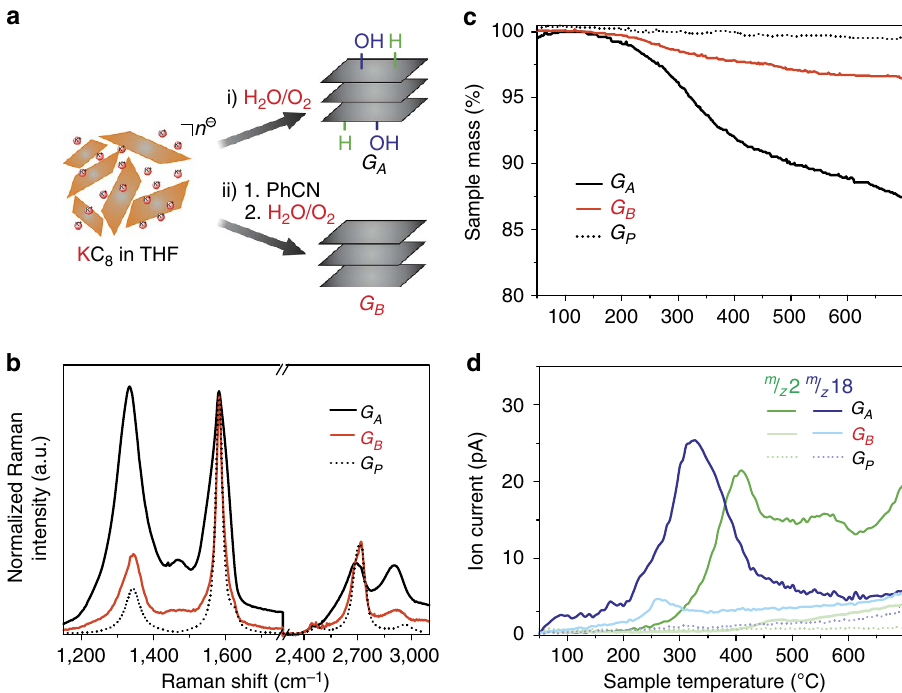
Figure 3 | Oxidative side-reactions of graphenides and the inhibition by PhCN treatment. ( a ) The sample is divided into two parts ( G A and G B ). In contrast to G A, G B was treated with PhCN before exposure to ambient conditions. The dotted line indicates pristine graphite ( G P ) being dispersed in THF and PhCN as reference. ( b ) Statistical Raman spectroscopy mean spectra of 10,000 measured pixels (100 (cid:4) 100 m m). ( c ) TG mass loss profiles of G A , G B and the reference G P . ( d ) Correlating MS traces for m/z 2 and 18 indicating hydrogenation and hydroxylation for G A and vanishing ion current detection in the case of the PhCN treated sample G B compared with the reference G P